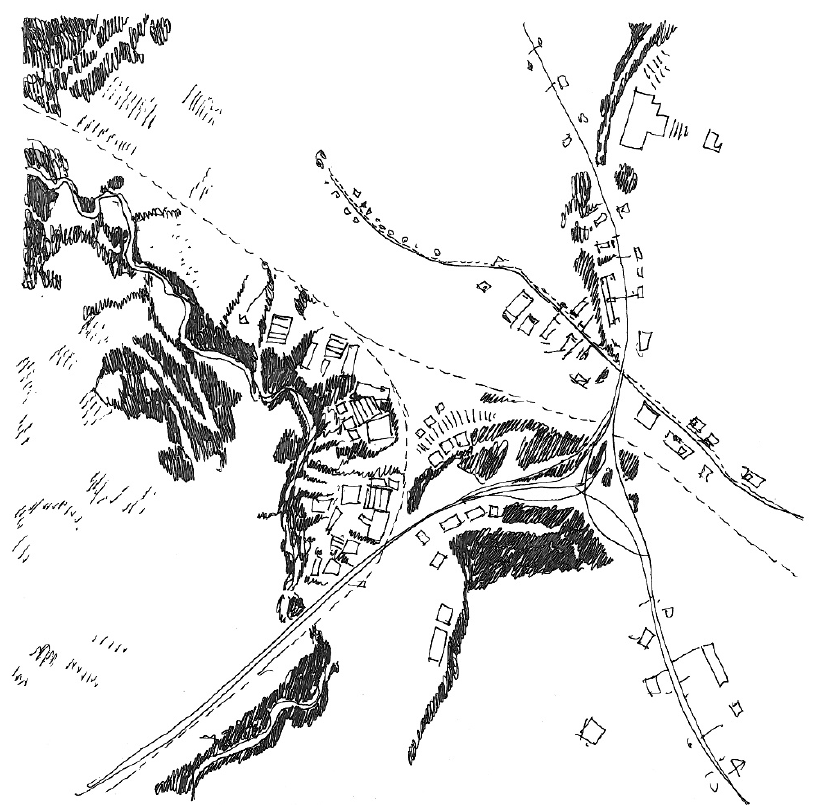
Figure 4. “Reestablishment of territorial connectivity.” West Lausanne Area: creation of new continuities between forested areas and industrial spaces. Insertion of new strategic urban axes and repurposing of the existing highway (integrated within the territory). Source: Horizontal Metropolis, a Radical Project , Venice Architecture Biennale 2016,